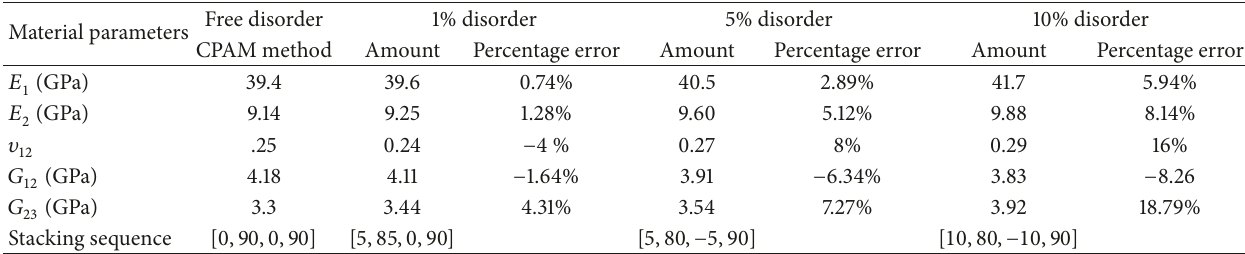
Table 14: Elastic constants determined for specimen D3 for different levels of